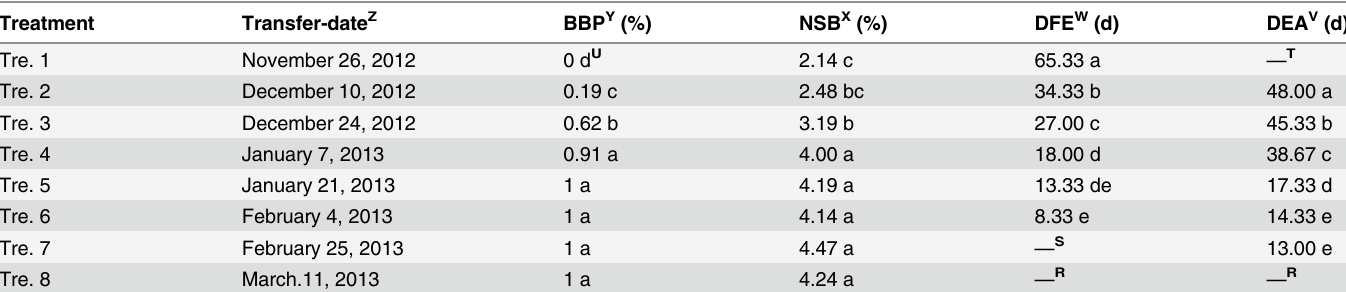
Table 1. Morphological observation for dormancy release evaluation of ‘ Hangbaishao ’